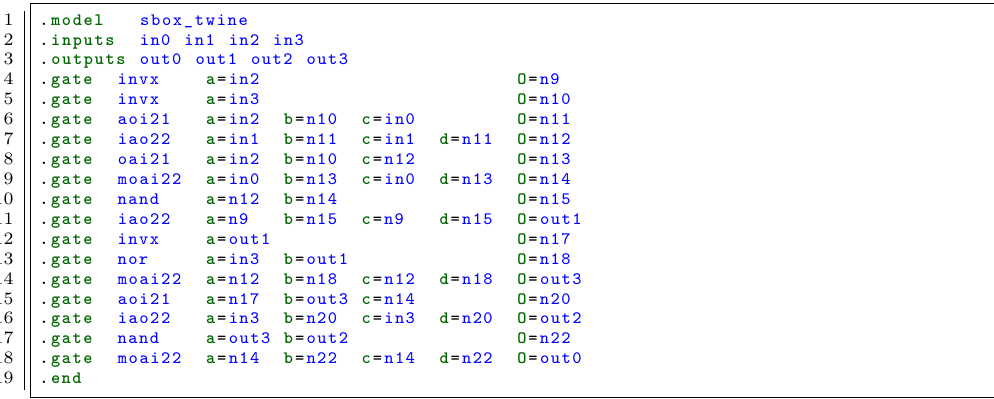
Figure 17: Combination of LIGHTER and ABC: Area-optimized hardware implementation of TWINE Sbox using 22.50 GE with the standard cell library of the TSMC 65nm logic process.